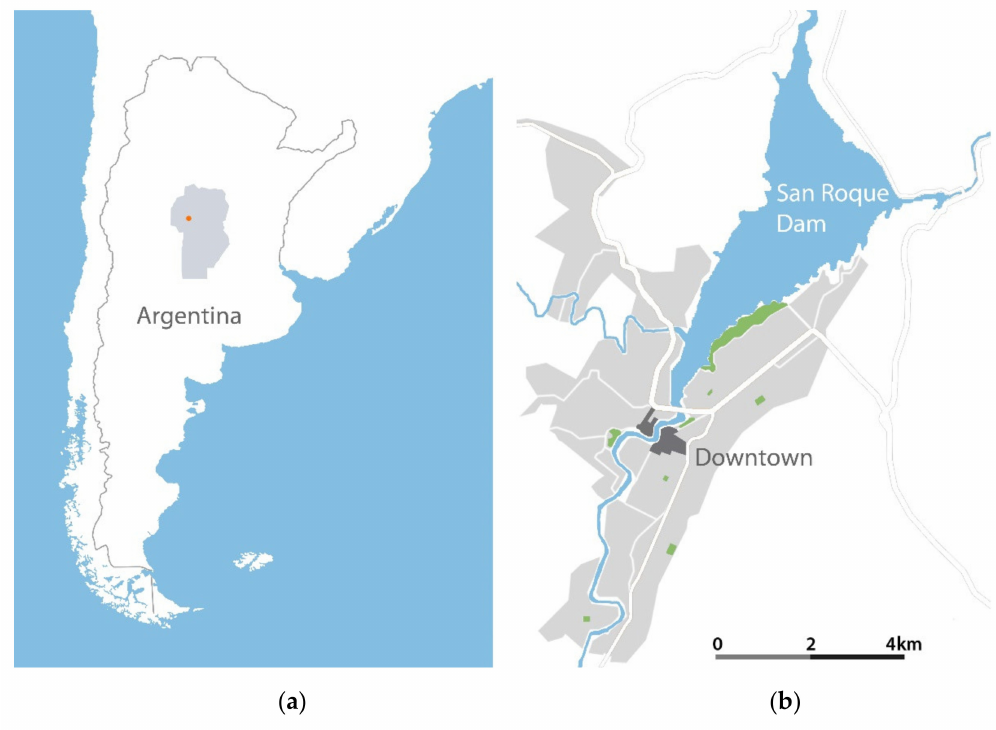
Figure 1. Location maps. ( a ) Argentina and Cordoba Province. ( b ) Villa Carlos Paz, the San Roque Dam, and the Downtown area on both sides of the San Antonio